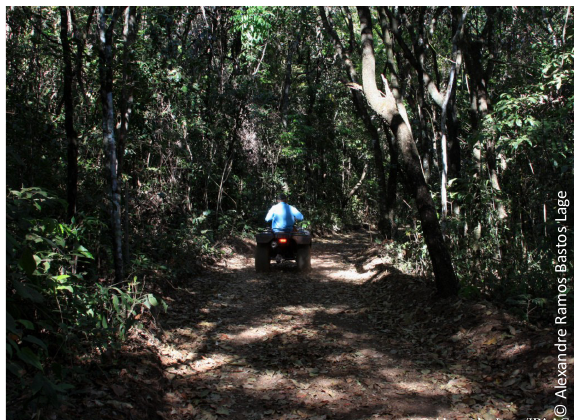
Image 3. Linear transect in a Gallery